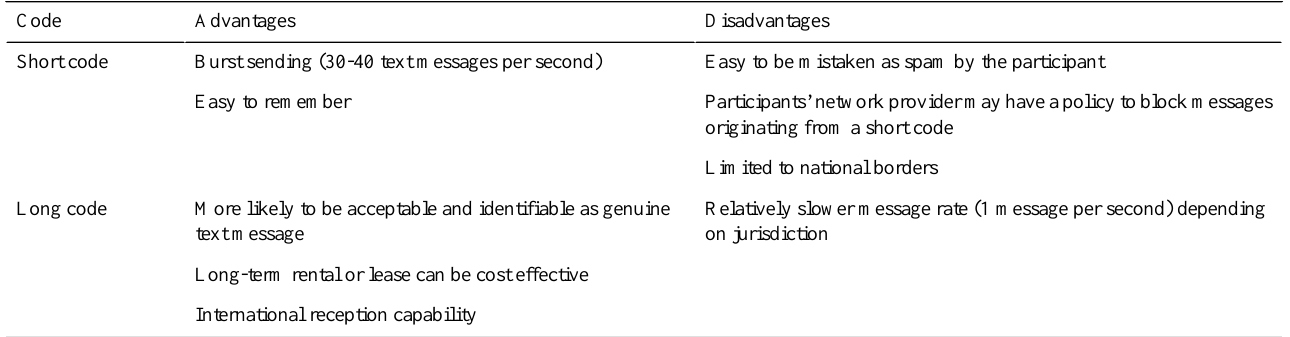
Table 3. Text message sending codes.